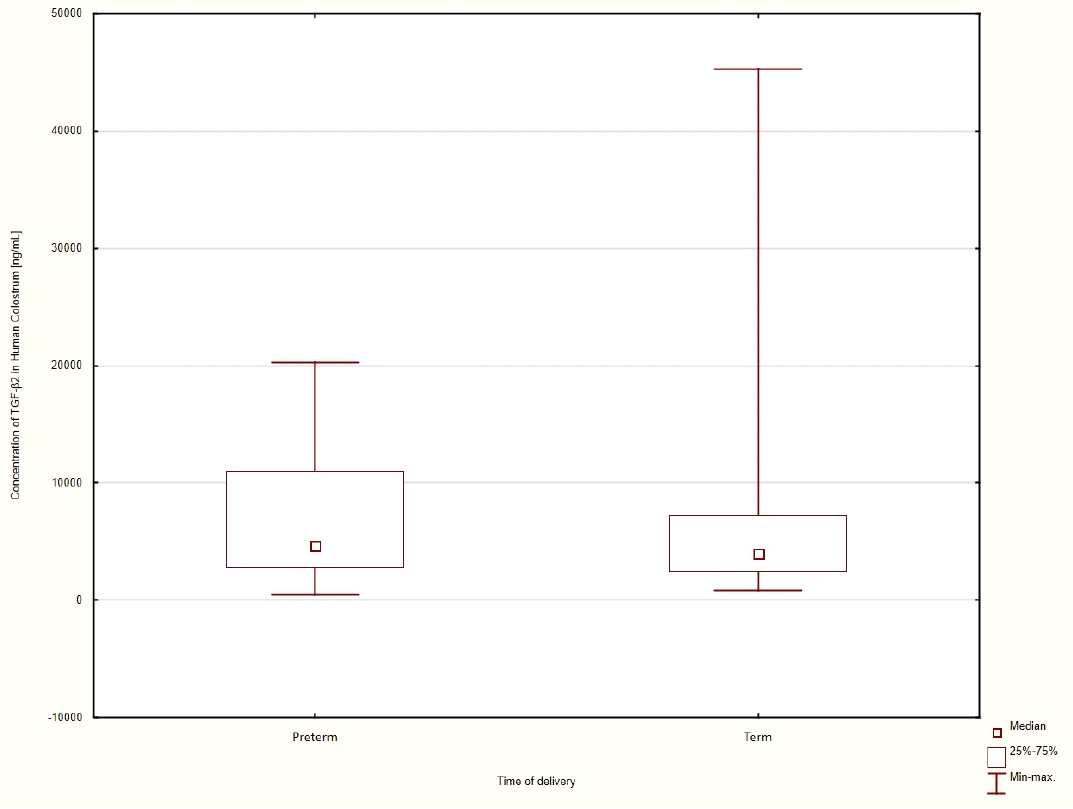
Figure 1. Comparison of the median TGF- β2 concentration in the human colostrum of patients had delivered at term and preterm.